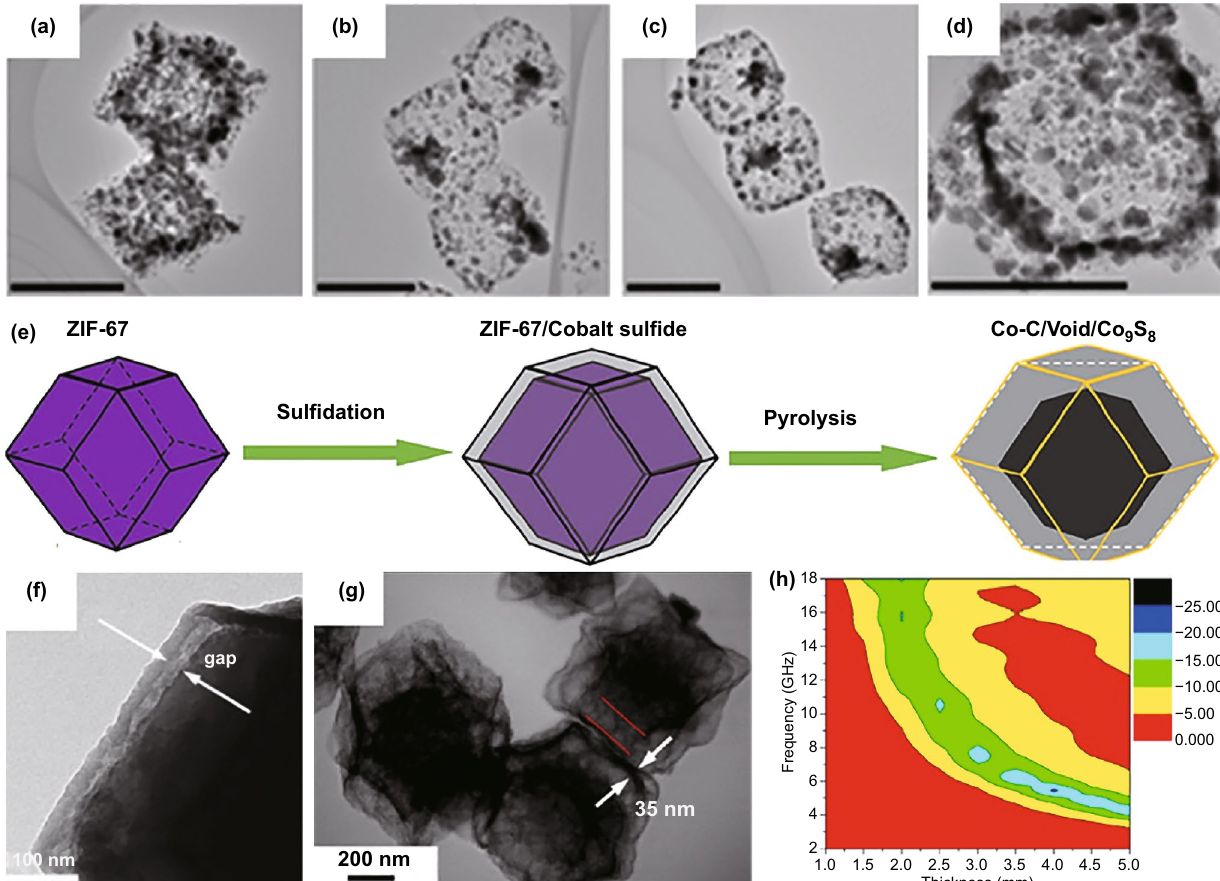
Fig. 11 TEM images of a CoNi@NG-NCP-30, b CoNi@NG-NCP-60, c CoNi@NG-NCP-90, and d CoNi@NG-NCP-120 (scale bars in the images: 500 nm). Reproduced with permission from Ref. [158] . Copyright © 2018 American Chemical Society. e Synthetic processes of the Co–C/Co 9 S 8 composite, TEM images of f ZIF-67/Co 9 S 8 -3 and g Co–C/Co 9 S 8 -3, and h RL map of Co–C/Co 9 S 8 -3. Reproduced with permission from Ref. [163] . Copyright © 2018